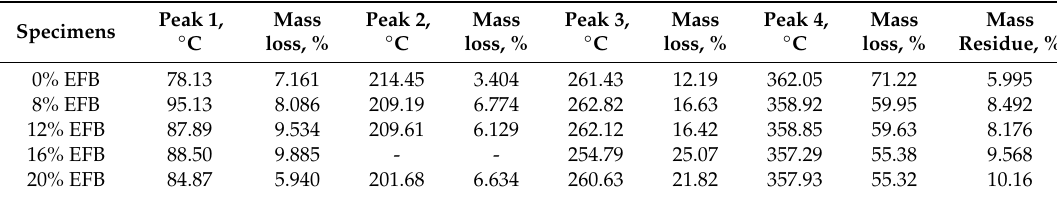
Table 3. A summary of peak temperatures for EFB composites.